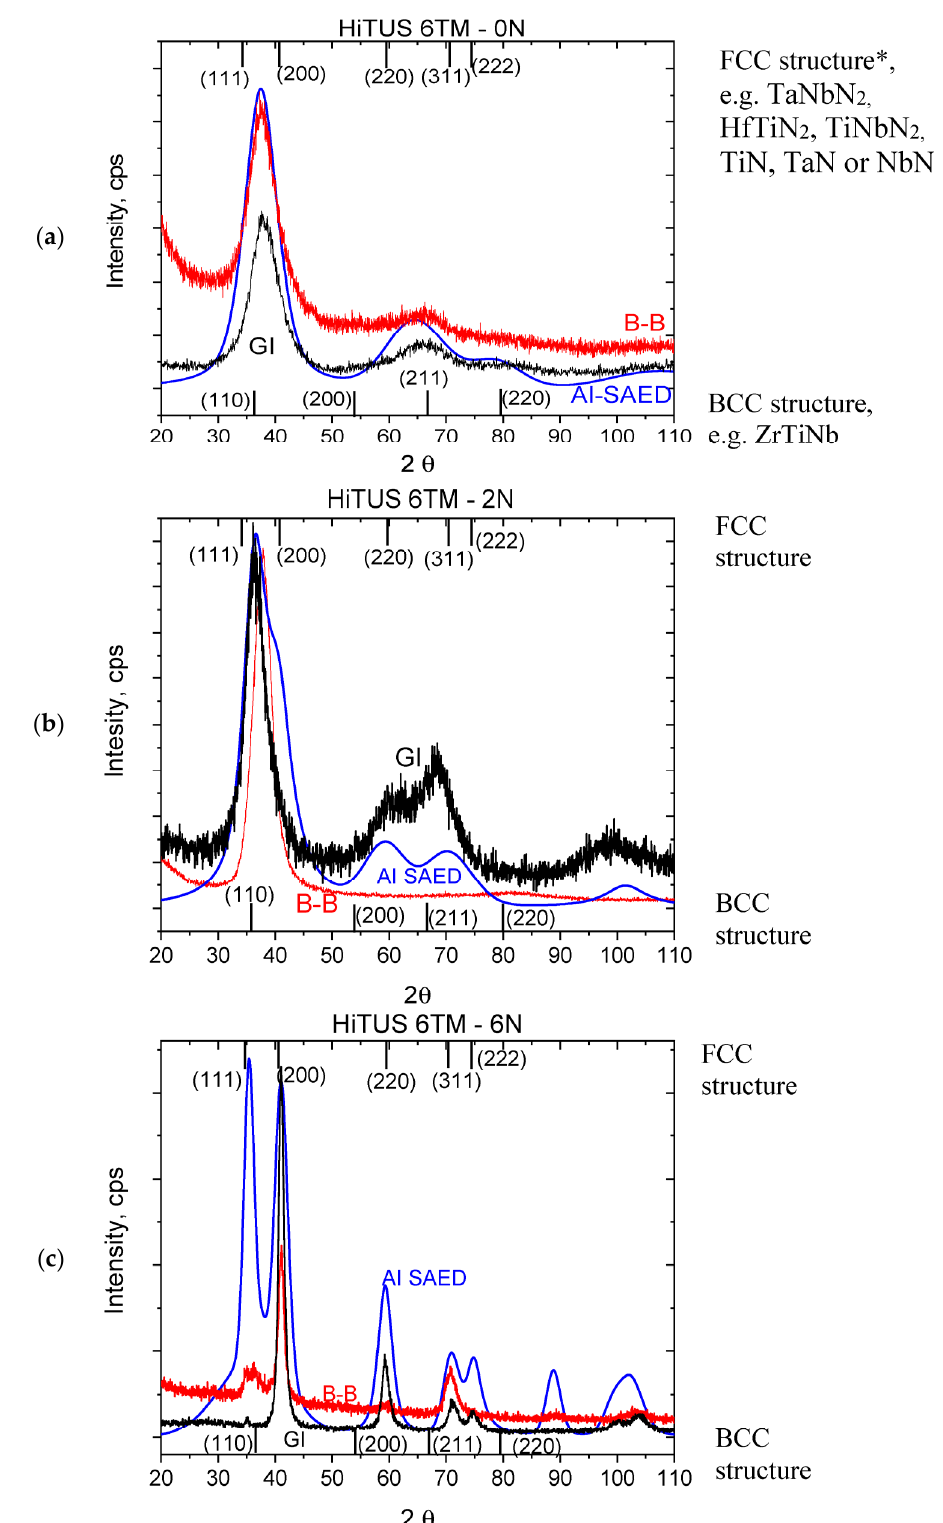
Figure 12. X-ray diffraction patterns of the studied reactive HiTUS TiNbVTaZrHf-xN (HT-6TM-xN) coatings in symmetrical θ /2 θ (Brag–Brentano (B-B)), grazing incidence (GI), and azimuthal integral of SAED (AI SAED) from TEM observations and prepared: ( a )—without nitrogen addition (0 sccm N 2 ); ( b )—with 2 sccm N 2 and ( c )—6 sccm N 2 . (*—from [47–50]).